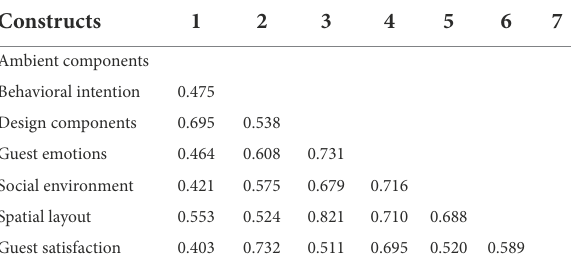
TABLE 5 Results of discriminant validity.